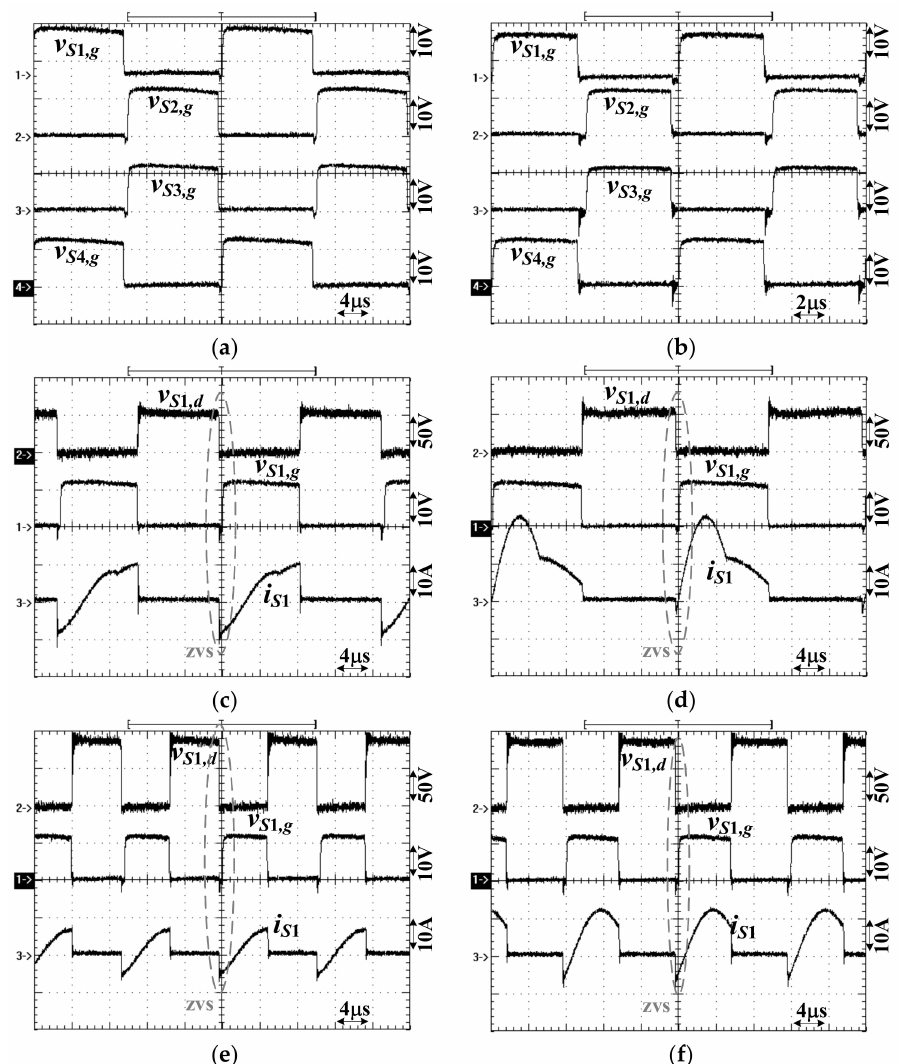
Figure 8. Experimental results of PWM signals for low input voltage region: ( a ) S 1 – S 4 at 50 V input and 100% power; ( b ) S 1 – S 4 at 90 V input and 100% power; ( c ) S 1 voltage and current at 50 V input and 20% power; (d) S 1 voltage and current at V in = 50 V input and 100% power; ( e ) S 1 voltage and current at 90 V input and 20% power; ( f ) S 1 voltage and current at 90 V input and 100%